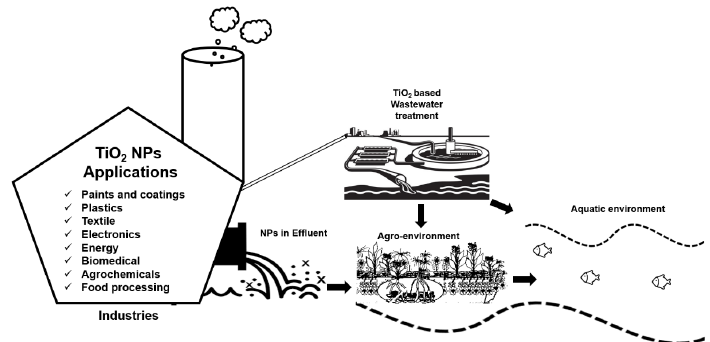
Figure 1. Illustration of the wide range of TiO 2 NPs applications from industries, their release into the wastewater, and their possible exposure routes towards the agro-environment.